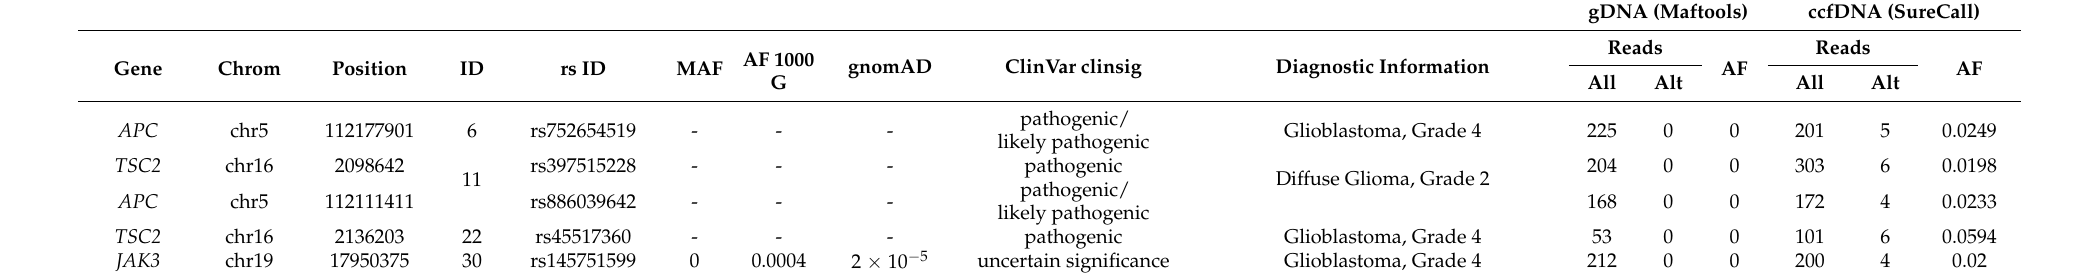
Table 2. Cosmic registered variants found in ccfDNA but not in